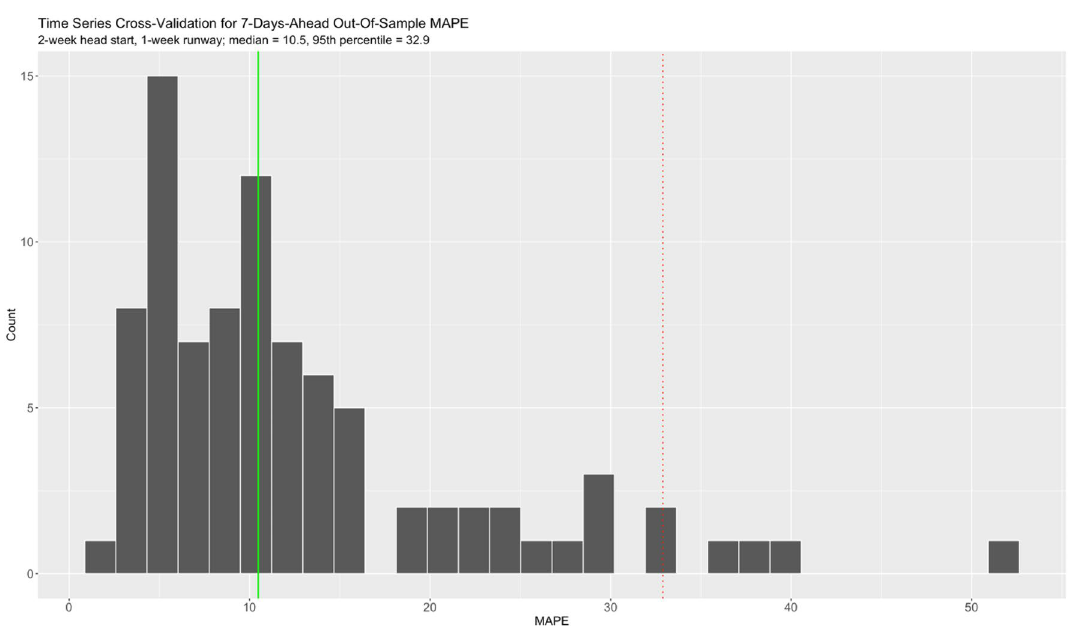
Figure 5. Distribution of 7-days-ahead out-of-sample MAPE under time series